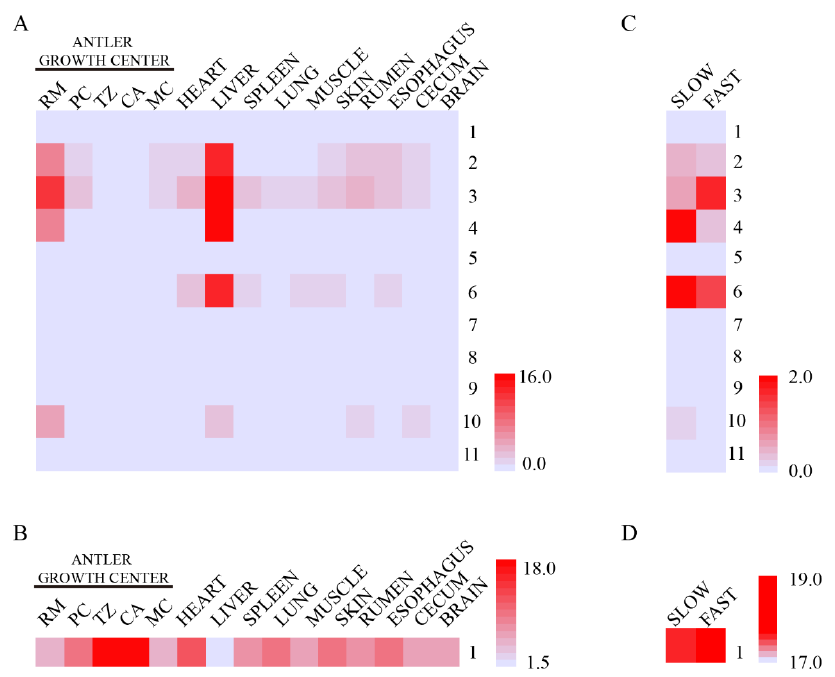
Figure 5. Transcript expression of IGF1 and IGF1R in antlers and different tissues of sika deer: ( A ) Expression of 11 transcripts of IGF1 gene in different tissues of sika deer. In addition to the liver (the main source of IGF1 ), the highest expression of IGF1 was found in the RM layer of the antler growth center. ( B ) Expression of the transcript of the IGF1R gene in different tissues of sika deer. The transcript expression level of IGF1R in the antler growth center was higher than in other tissues and organs. ( C ) Expression of 11 transcripts of the IGF1 gene in antlers with different growth rates. The expression levels of transcripts 3 and 4 of the IGF1 gene were significantly different between the faster and slower-growing antlers. ( D ) Expression of the transcript of the IGF1R gene in antlers with different growth rates. There were no different expression levels of the transcripts of the IGF1R gene found between faster and slower-growing antlers.